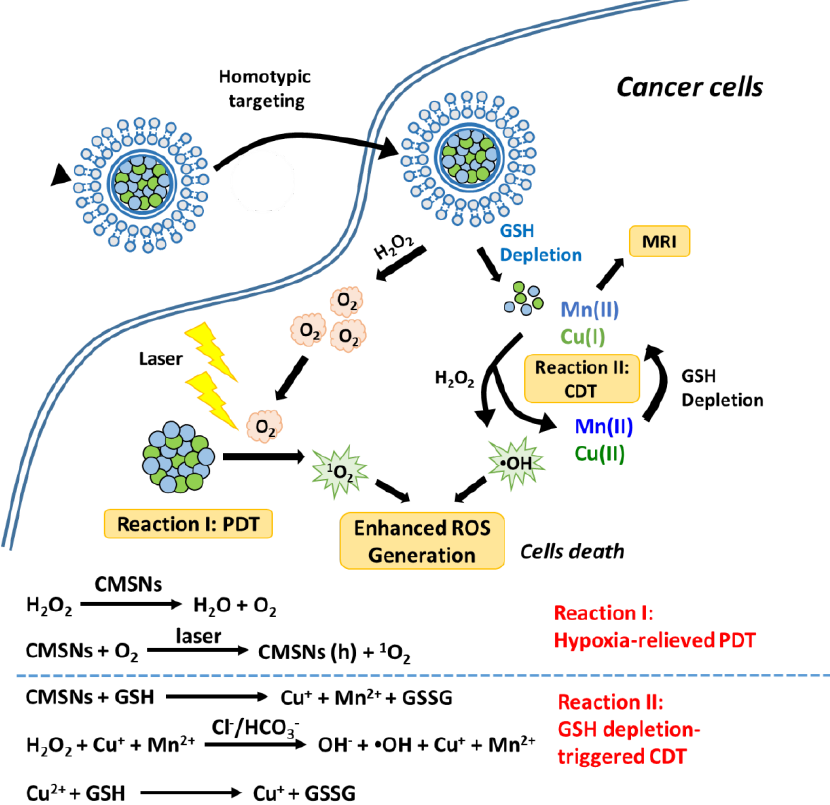
Figure 5. Schematic illustration of the therapeutic mechanism of copper/manganese silicate nanosphere (CMSN)-based chemodynamic therapies (CDT)/PDT combination therapy. Reproduced with permission [95]. Copyright 2019, American Chemical Society.